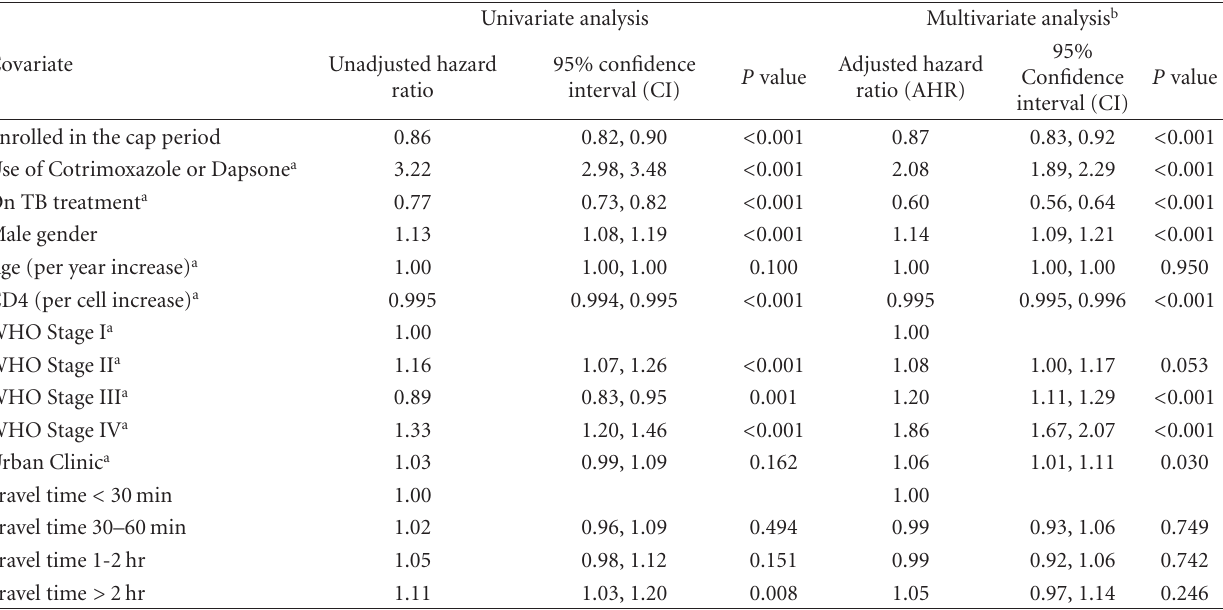
Table 2: Cox proportional (unadjusted and adjusted) hazard ratios for predictors of cart initiation.